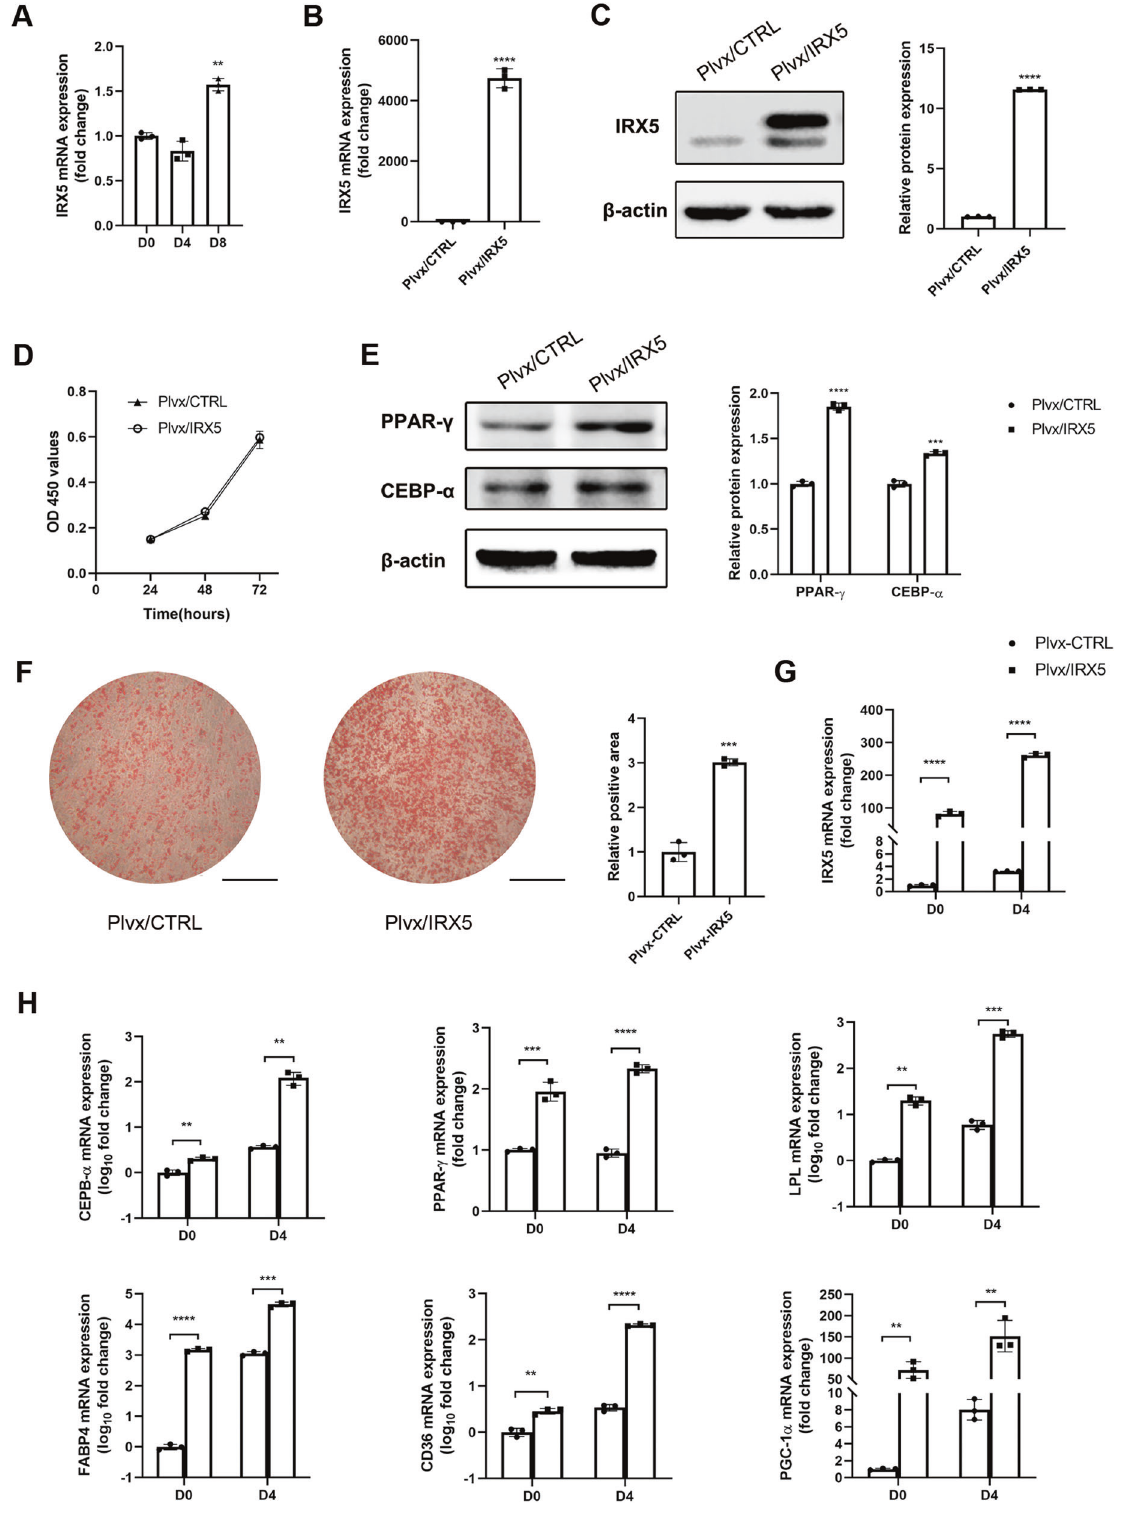
Fig. 2 In fl uence of IRX5 overexpression on adipogenic differentiation of hMSCs. A Endogenous mRNA levels of IRX5 during adipogenic differentiation at D0, D4 and D8. B , C IRX5 overexpression ef fi ciency were determined by qRT-PCR ( B ) and Western blot ( C ). D CCK-8 assay. E Protein levels of PPAR- γ and CEBP- α in Plvx/CTRL and Plvx/IRX5 groups by western blot assay. F Oil red O staining was performed at D16 after adipogenic induction. G mRNA levels of IRX5 during adipogenic differentiation at D0 and D4 in Plvx/CTRL and Plvx/IRX5 groups. H mRNA levels of CEBP- α , PPAR- γ , LPL , FABP4 , CD36 and PGC-1 α during adipogenic differentiation at D0 and D4. Scale bar, 500 μ m. Results are shown as mean ± SD. n = 3. * p < 0.05, ** p < 0.01, *** p < 0.001, **** p < 0.0001.